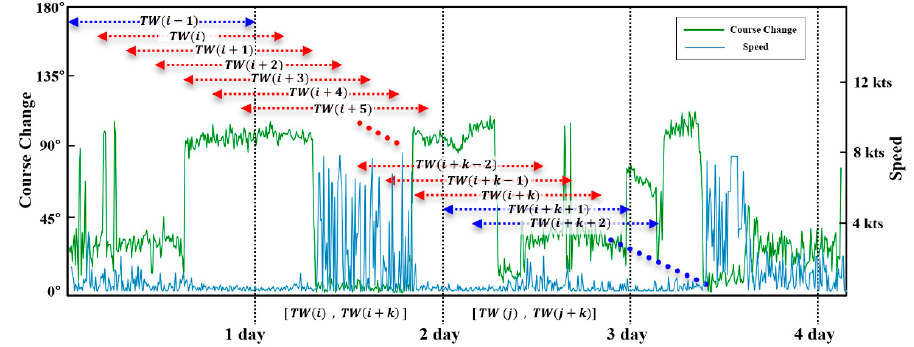
Figure 5. Trajectory window data TW ( i ) over the sliding trajectory window